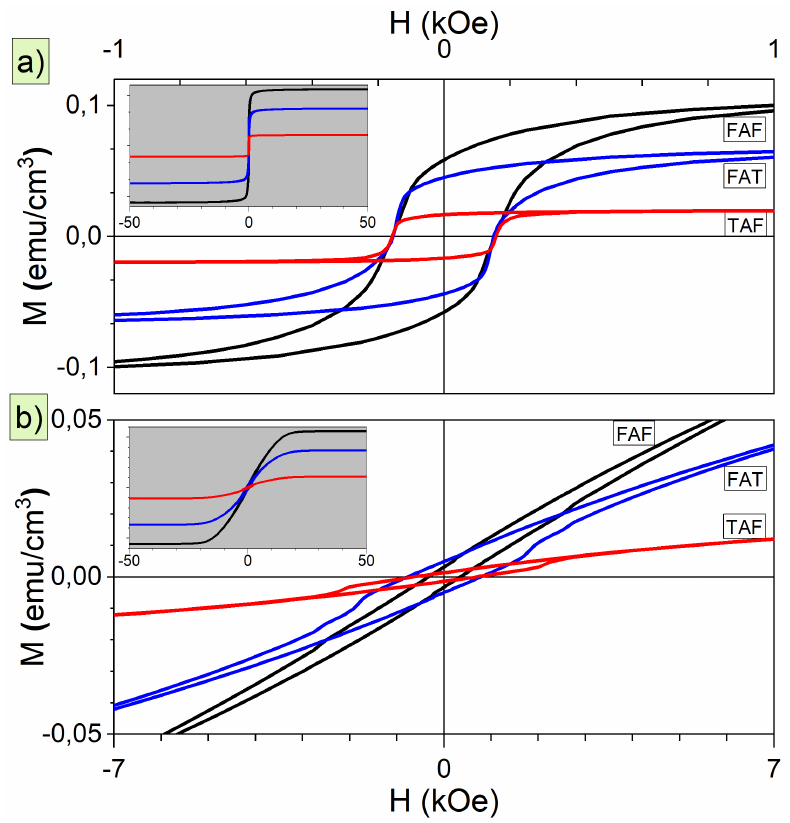
Figure 4. Field dependent magnetization curves for FAF, FAT, and TAF junctions measured at room temperature for ( a ) H (cid:107) S and ( b ) H ⊥ S geometry. The insets show the M ( H ) curves in the range of a magnetic field of ± 50